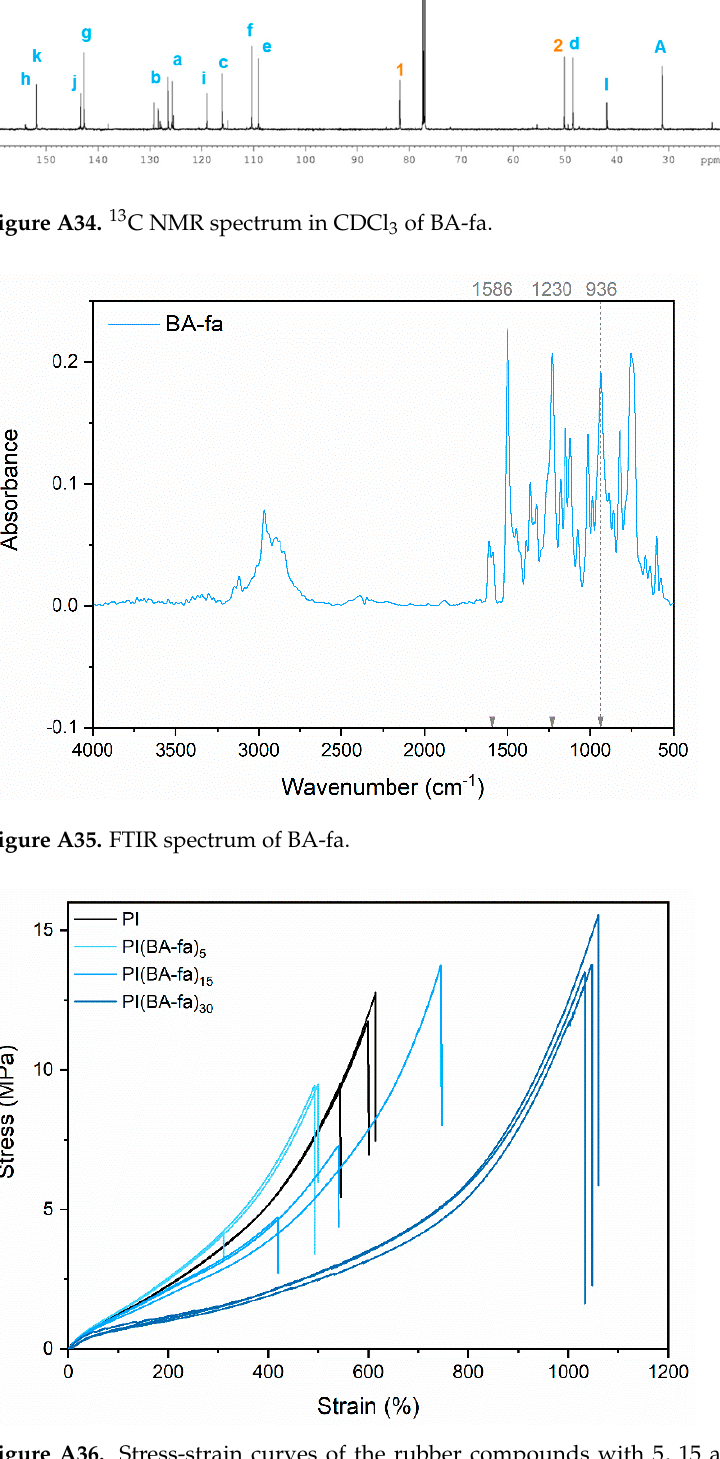
Figure A36. Stress-strain curves of the rubber compounds with 5, 15 and 30 phr of BA-fa and the reference. Table A2. Summary of the mechanical properties of the rubber compounds containing BA-fa.